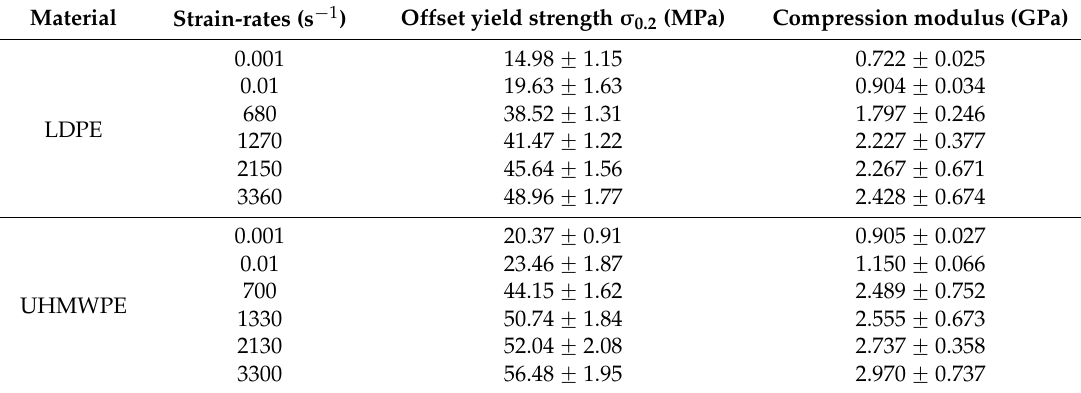
Table 4. Summary of compression test results for LDPE and UHMWPE for a range of strain-rates. Averages of multiple tests are shown